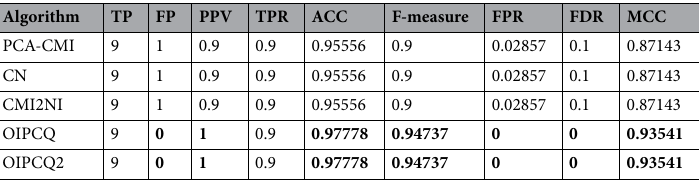
Table 2. Results for DREAM3-size10-Yeast1. Best results are indicated in bold.